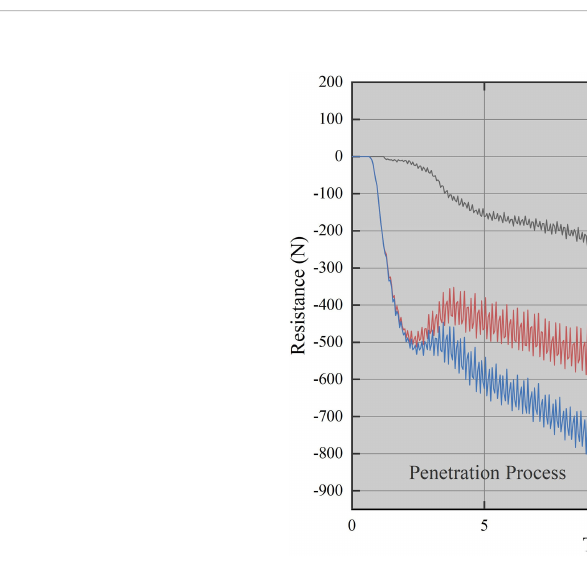
FIGURE 6 The resistance of ADP during the entire deployment